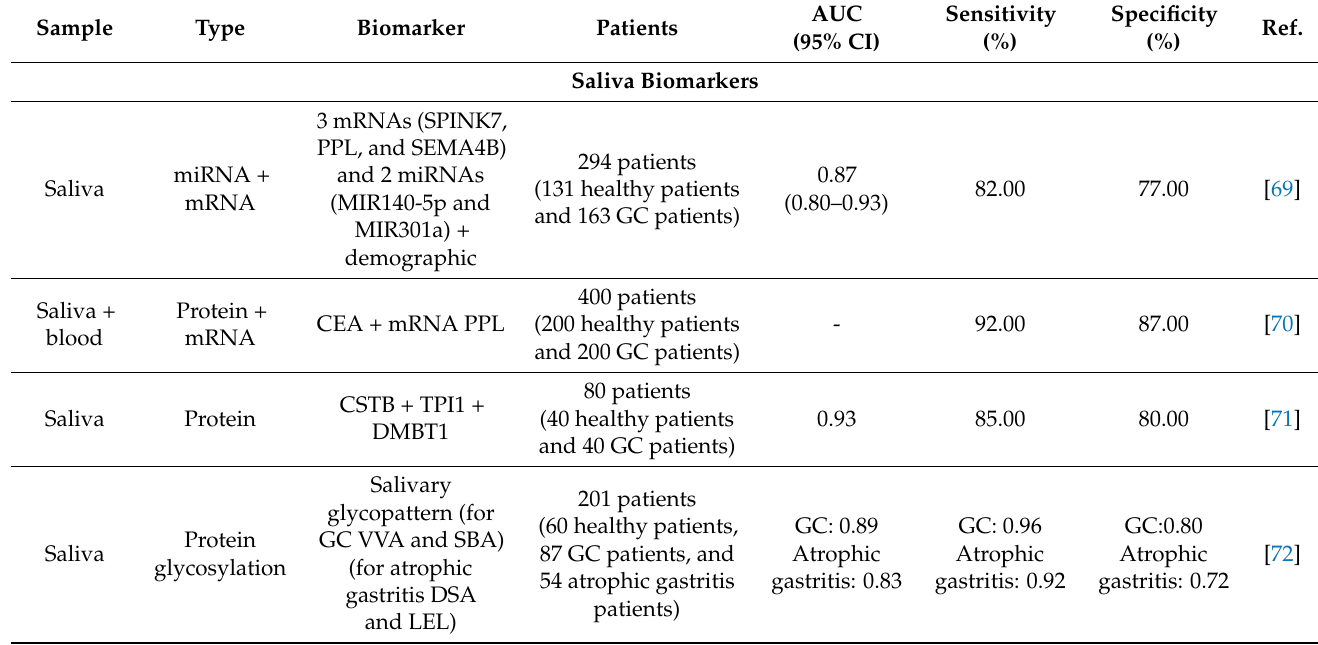
Table 2. Summary of potential saliva biomarkers for gastric cancer screening and early